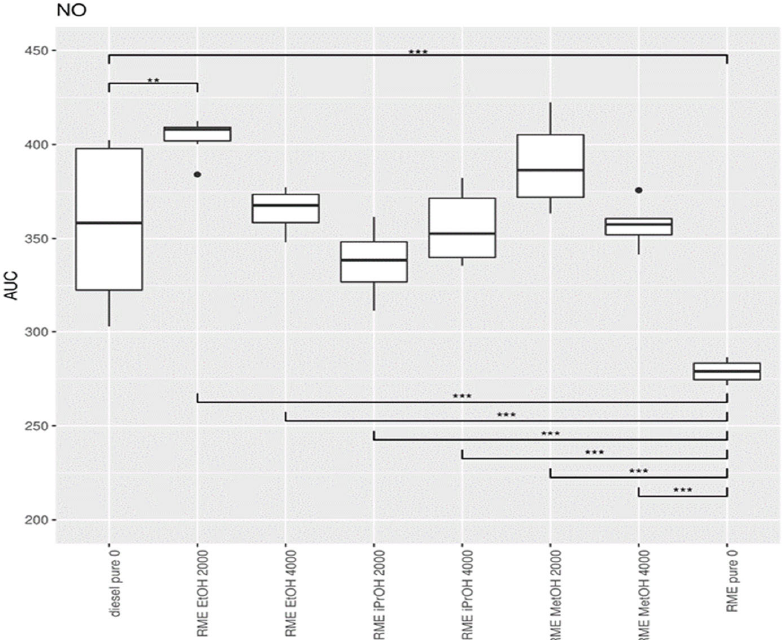
Figure 14. Boxplot of the statistical analysis of the concentration of NO in the exhaust gas. The center lines show the mean AUC value, obtained through bootstrap resampling. Asterisks show the significance of the pairwise comparison of the AUC values ** = p < 0.01; *** = p < 0.001).